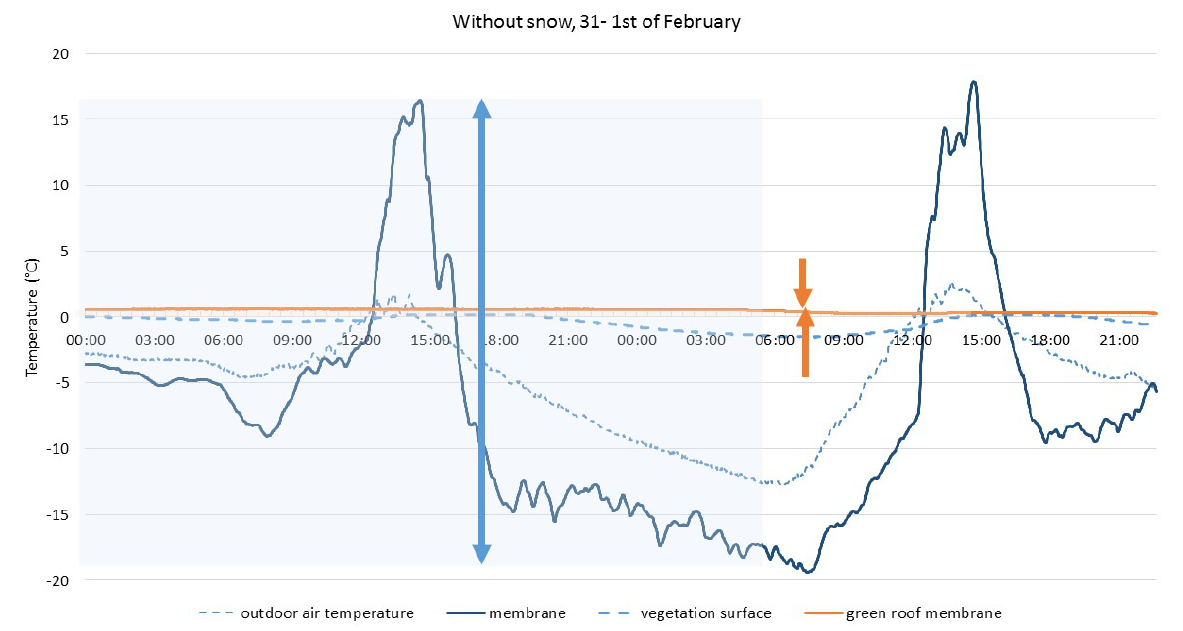
Figure 6. Temperature courses for two days without snow on the roof. Daily difference on the membrane is 37 °C, green roof membrane 0.4 °C. Air temperature difference is 15.5